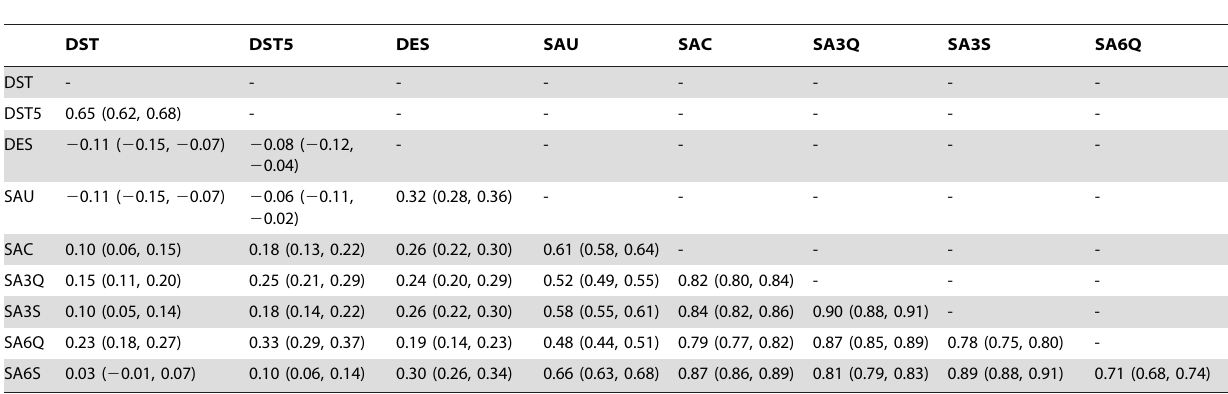
Table 4. Weighted Kappa (95% confidence intervals) for nine GIS-based measures of access to mammography in St. Louis.